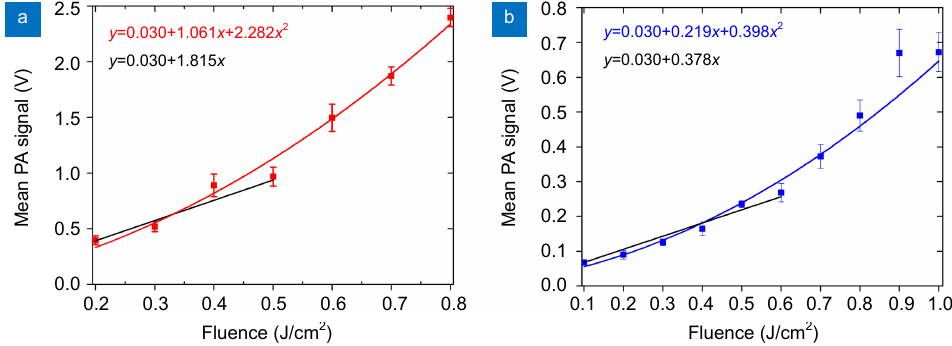
Fig. 5 | Mean PA signal for varying fluence values for the 1064 nm (a) and 355 nm (b) laser beam . The black line corresponds to the poly-